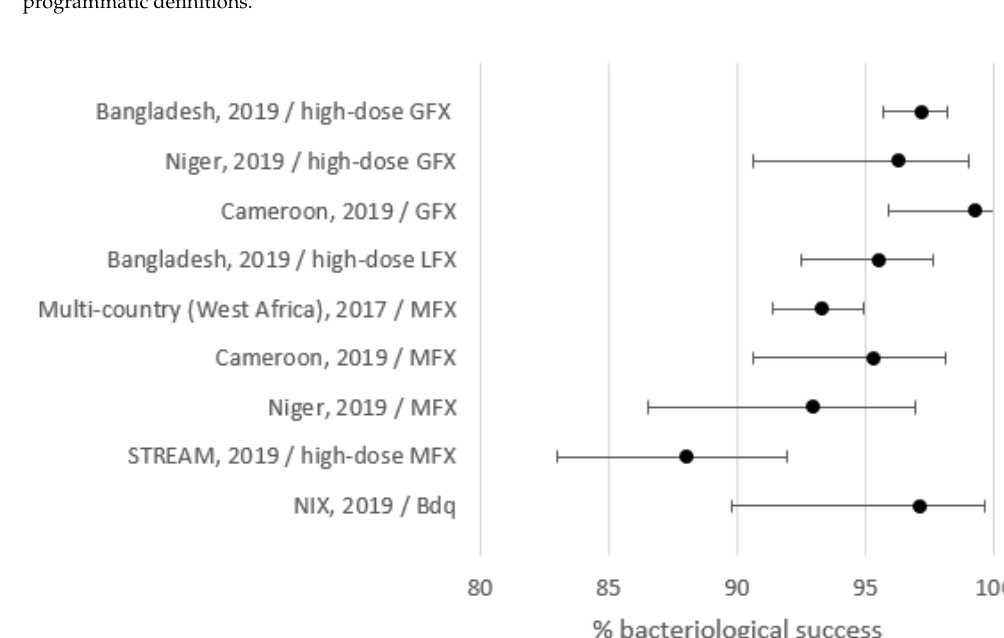
Table 2. Outcomes reported in published studies on short-course regimens.